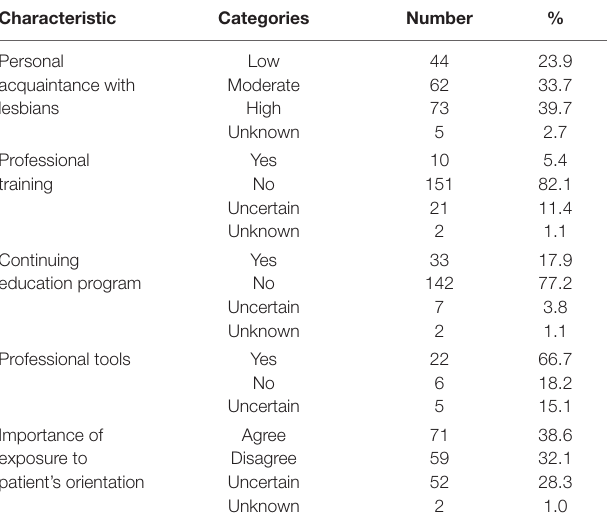
TABLE 2 | Nurses’ acquaintance with lesbians: categorical variables ( N = 184).